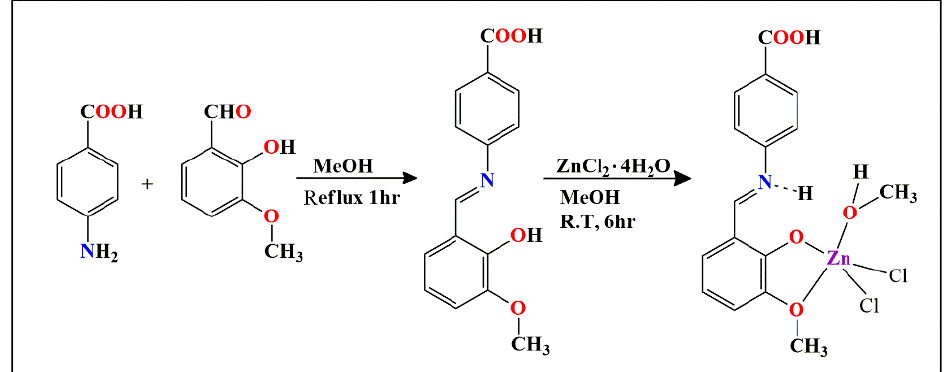
Scheme 1. Synthetic scheme of 4-((2-hydroxy-3-methoxybenzyl)amino)benzoic acid (H 2 L) and complex